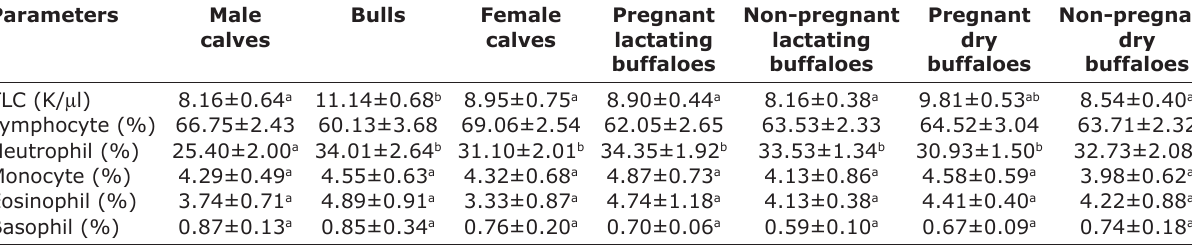
Table-2: Leukocytic indices of different experimental groups of Banni buffaloes.